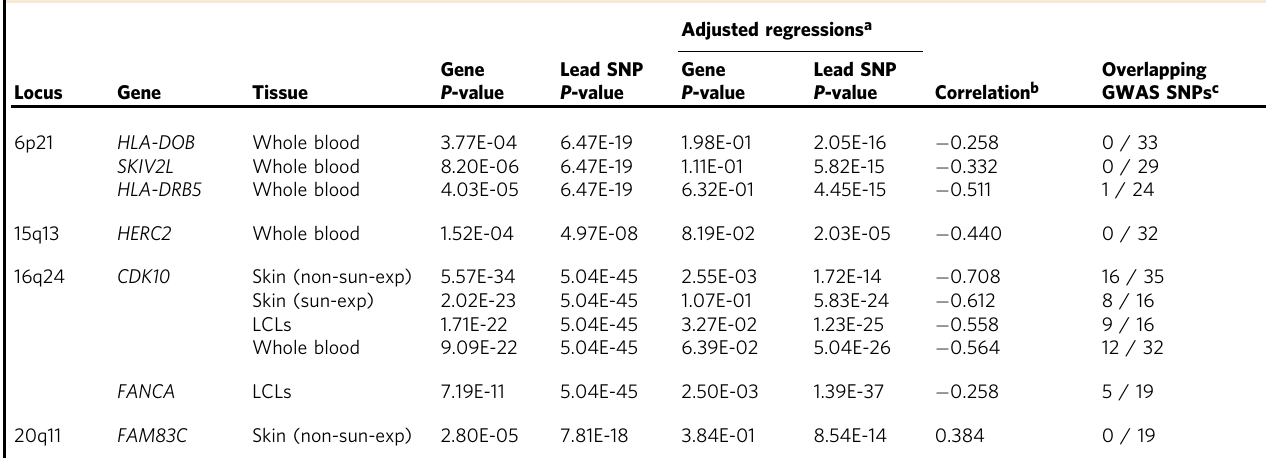
Table 2 Comparison of TWAS genes and GWAS lead SNPs in shared loci